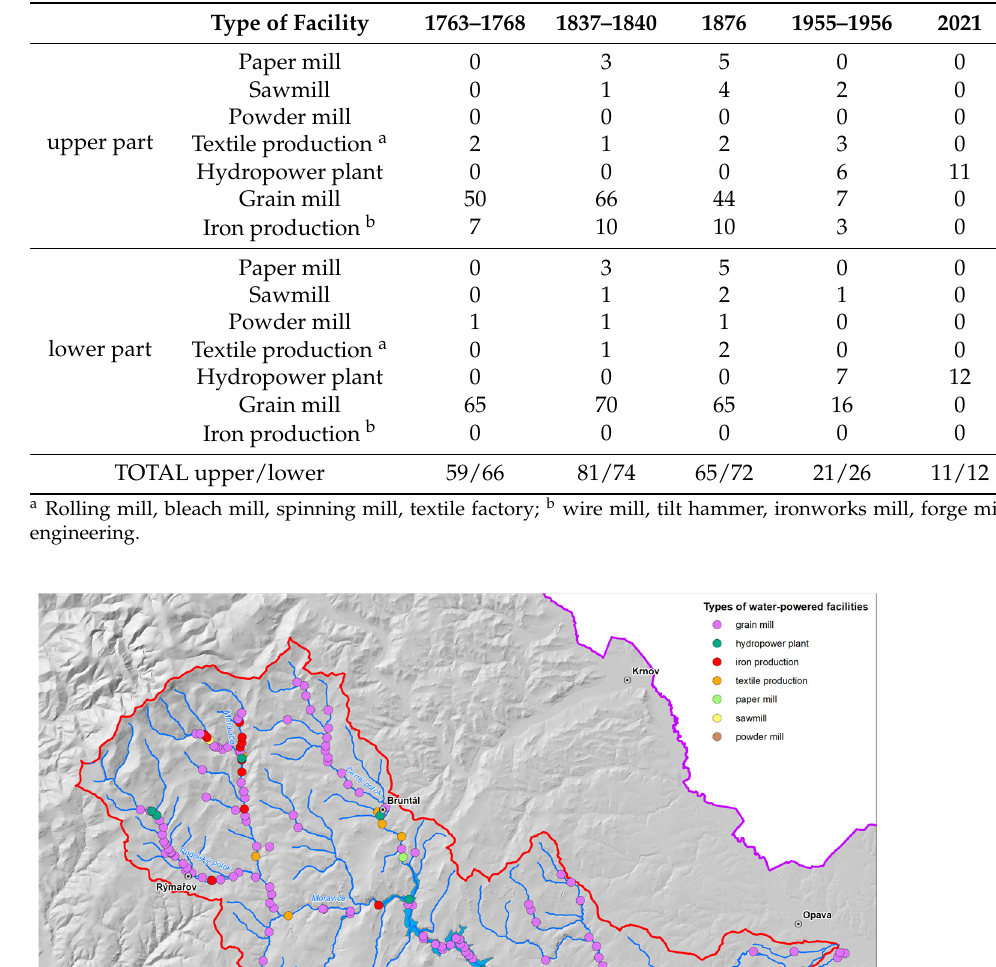
Table 3. The types of water-powered facilities recorded in the topographic maps of the upper and the lower parts of the Moravice river basin.